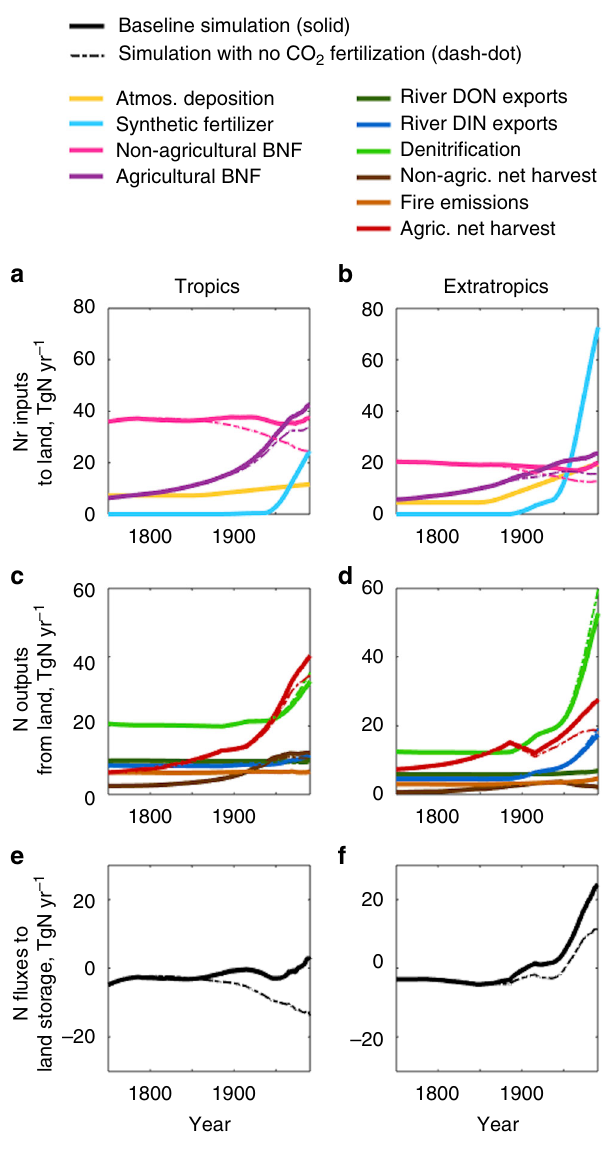
Fig. 5 Land N fl uxes in the tropics and extratropics. a , b Land Nr inputs include atmospheric deposition (light orange), synthetic fertilizers (sky- blue), biological N fi xation (BNF) in non-agricultural (plum) and agricultural (purple) lands. c , d Land N outputs include river dissolved organic N (DON) exports (green), river dissolved inorganic N (DIN) exports (blue), soil and freshwater denitri fi cation (light green), fi re emissions (orange), net harvest in agricultural (red) and non-agricultural (brown) lands. e , f N fl uxes to land storage. Solid thick lines show the baseline simulation. Dash-dot thin lines show the no-CO 2 fertilization simulation. All plots show 30-year moving averages from 1750 to